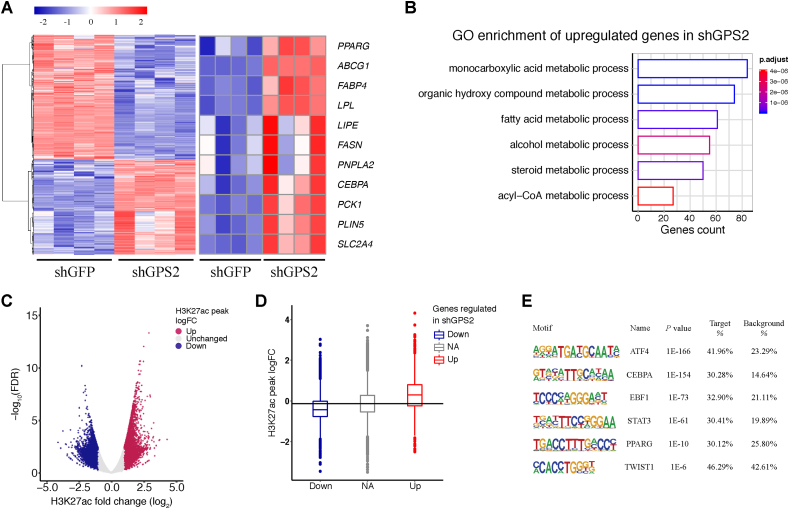
GPS2 depletion in preadipocytes increases transcription of genes involved in lipid metabolism in mature adipocytes. (A) Heatmap of significantly changed (adj. p-value < 0.05 and LogFC > 0.5 of LogFC < −0.5) gene expression in shGFP vs shGPS2 adipocytes at day 14 (left panel) and selection of adipocyte marker genes (right panel) (n = 4). (B) Gene ontology enrichment of significantly upregulated genes in shGPS2 adipocytes. (C) Volcano plot showing the average logFC of H3K27ac peaks in shGPS2 vs shGFP mature adipocytes (n = 2). (D) Box plot representing average logFC of co-localized H3K27ac peaks in downregulated, unregulated, and upregulated genes in shGPS2 cells at day 14. (E) Transcription factor motif analysis of GPS2-occupied regions in mature human adipocytes.